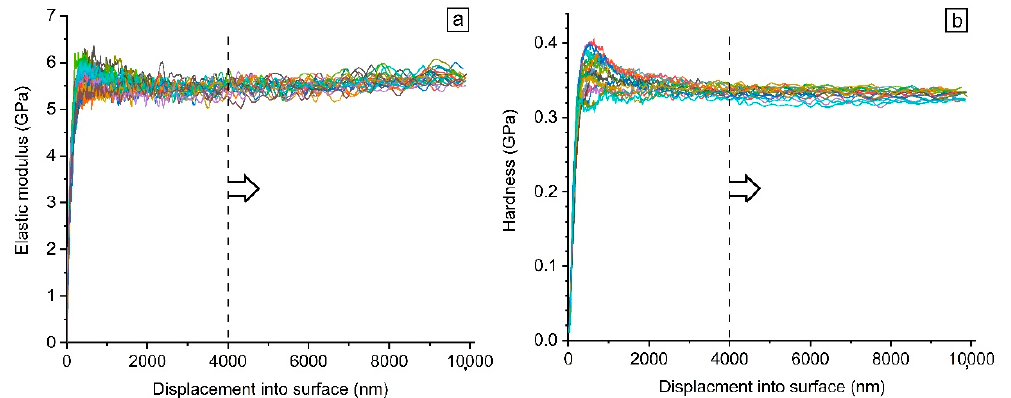
Figure 9. Typical variation of the ( a ) elastic modulus and ( b ) hardness with indentation depth.